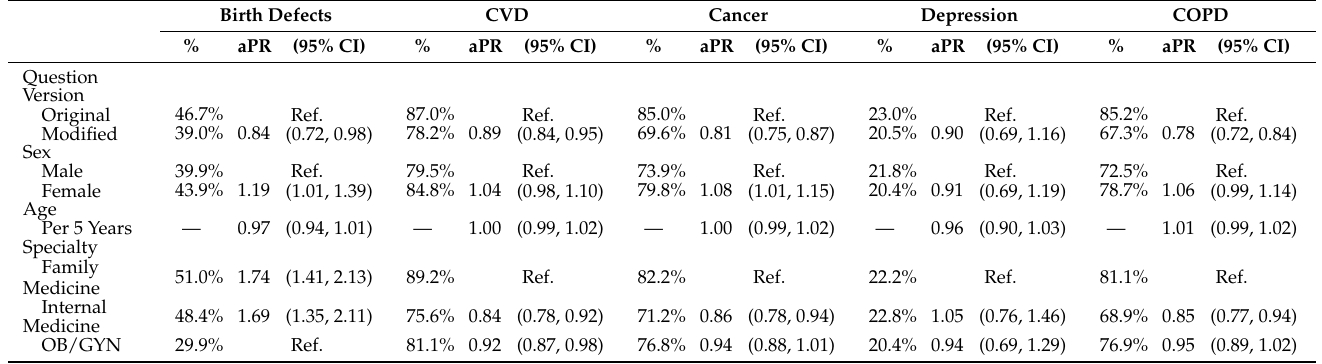
Figure 1. Association between question version and “strongly agreeing” that nicotine directly contributes to each health effect. Adjusted for age, gender, and specialty. Table 3. Prevalence of and multivariable associations with “strongly agreeing” that nicotine directly contributes to each health effect.